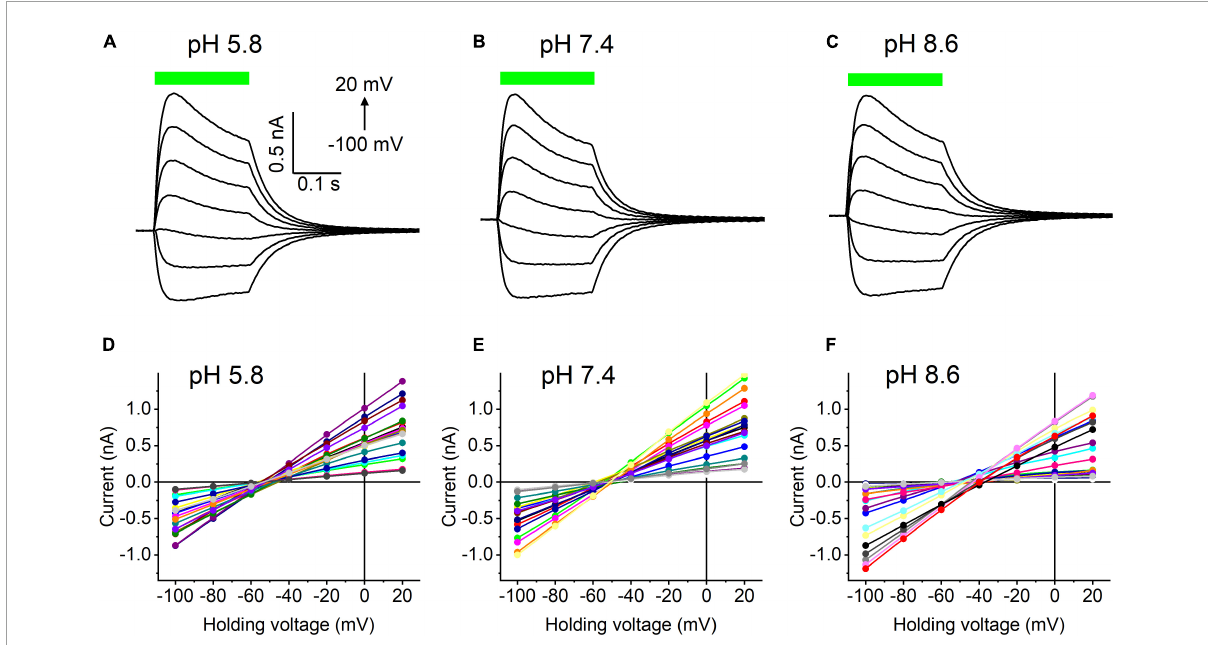
FIGURE2 (A–C) Photocurrent traces recorded from Hc KCR1 at the indicated external pH in response to a 200-ms light pulse (530 nm, 900 mA), the duration of which is shown as a colored bar on top. The holding voltage was varied from –100 to 20 mV in 20-mV steps. (D–F) Current-voltage relationships of Hc KCR1 measured in individual cells. The current amplitude was measured at the end of a 200-ms light